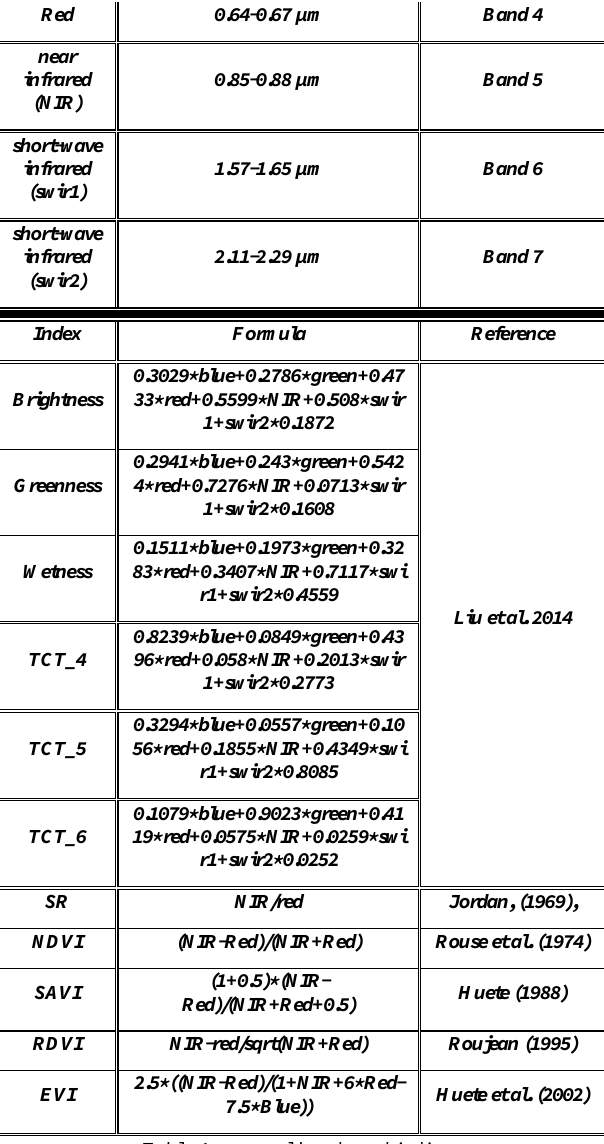
Table 1: spectral bands and